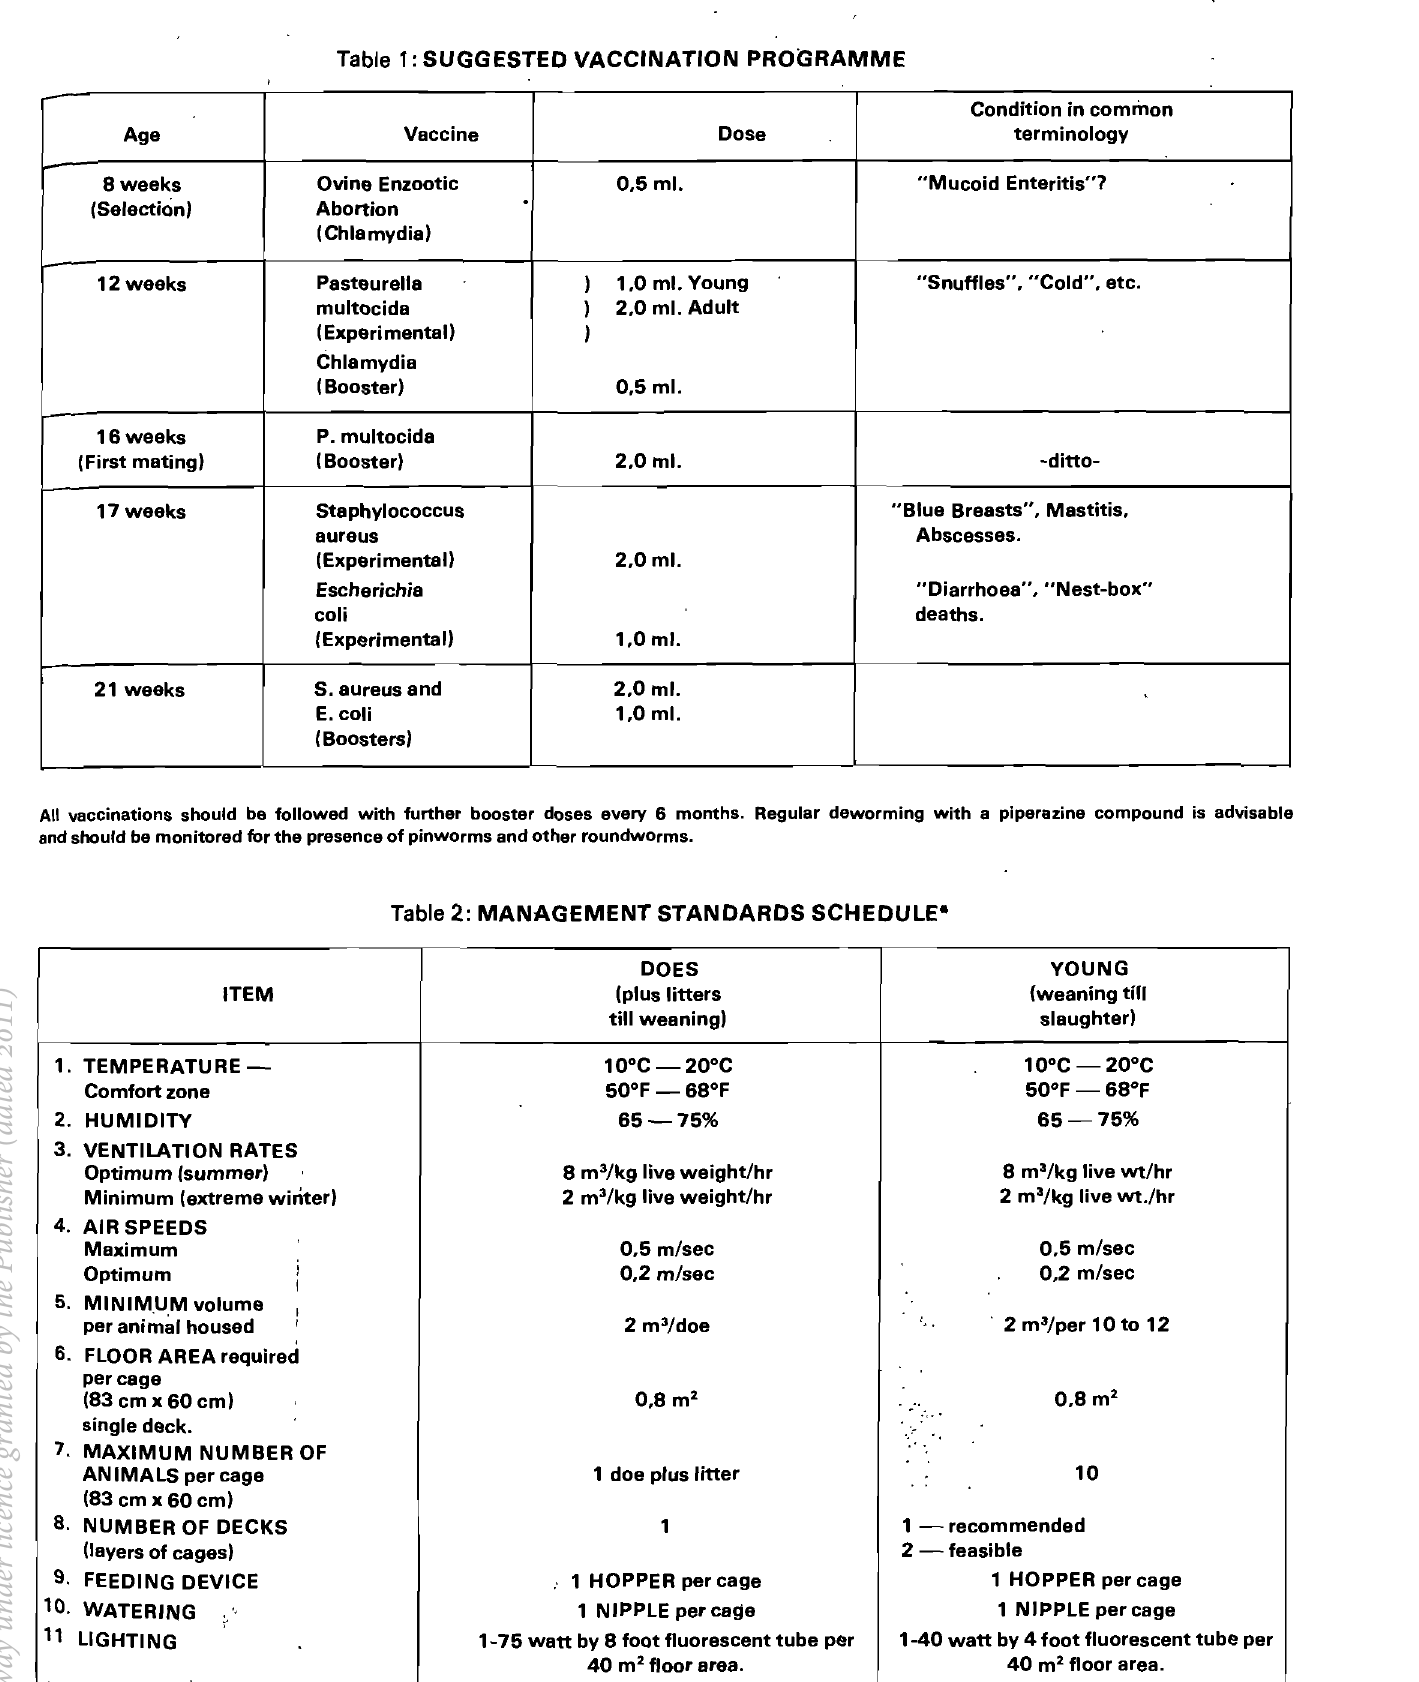
Table 1: SUGGESTED VACCINATION PROGRAMME